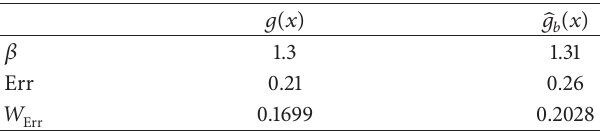
Table 4: Error on mean waiting times of 𝑀/𝑀/1 and 𝐺/𝑀/1